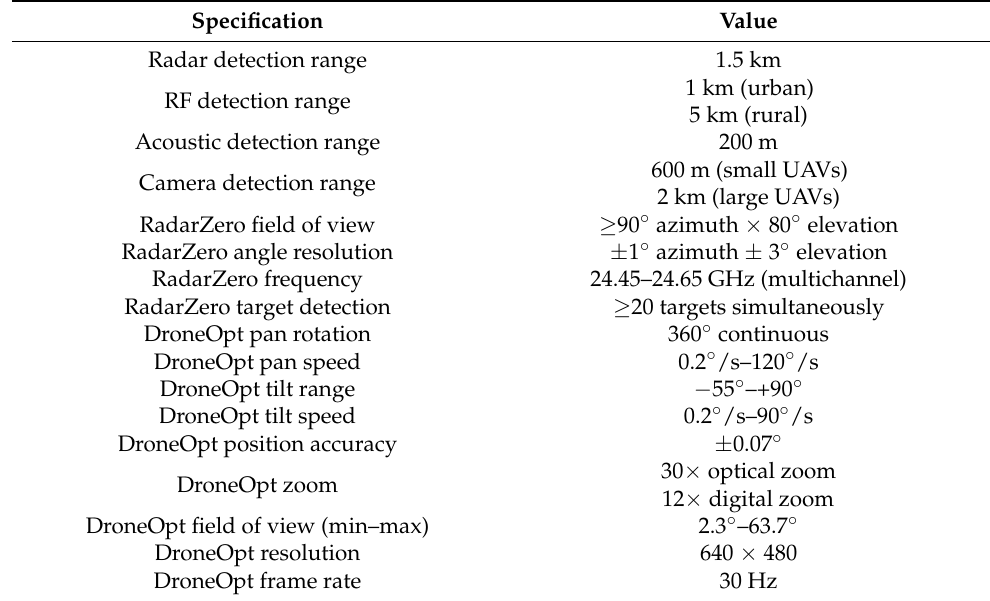
Table 13. DroneSentry integrated system